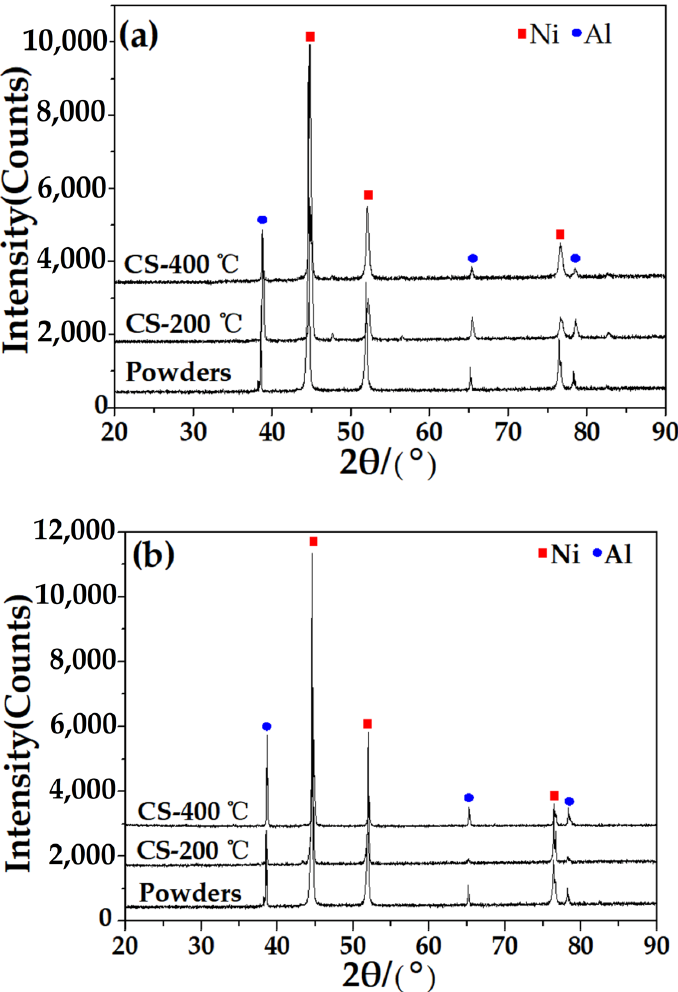
Figure 11. XRD patterns of Ni-coated Al coatings deposited onto an ( a ) Al substrate and ( b ) Q235 steel substrate.